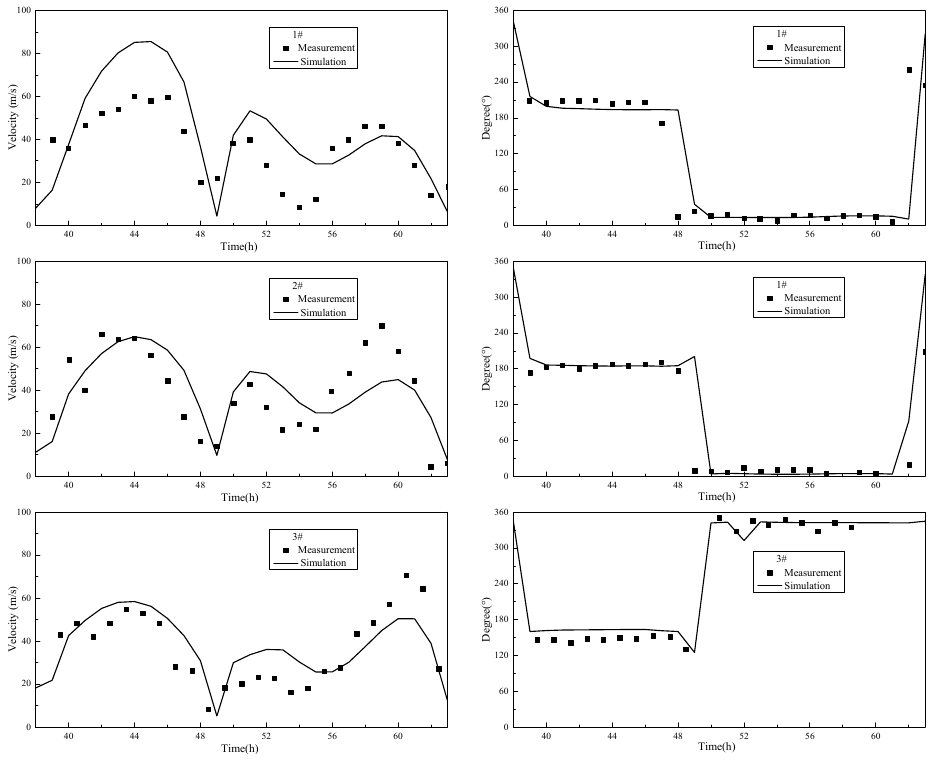
Figure 2. Comparisons of measured and calculated velocity and direction of spring tides.